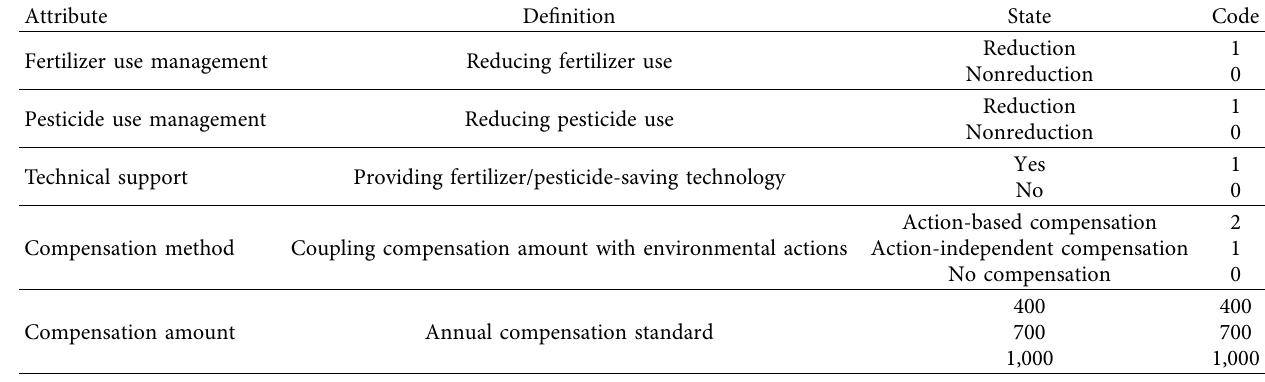
Table 2: Attributes and states.